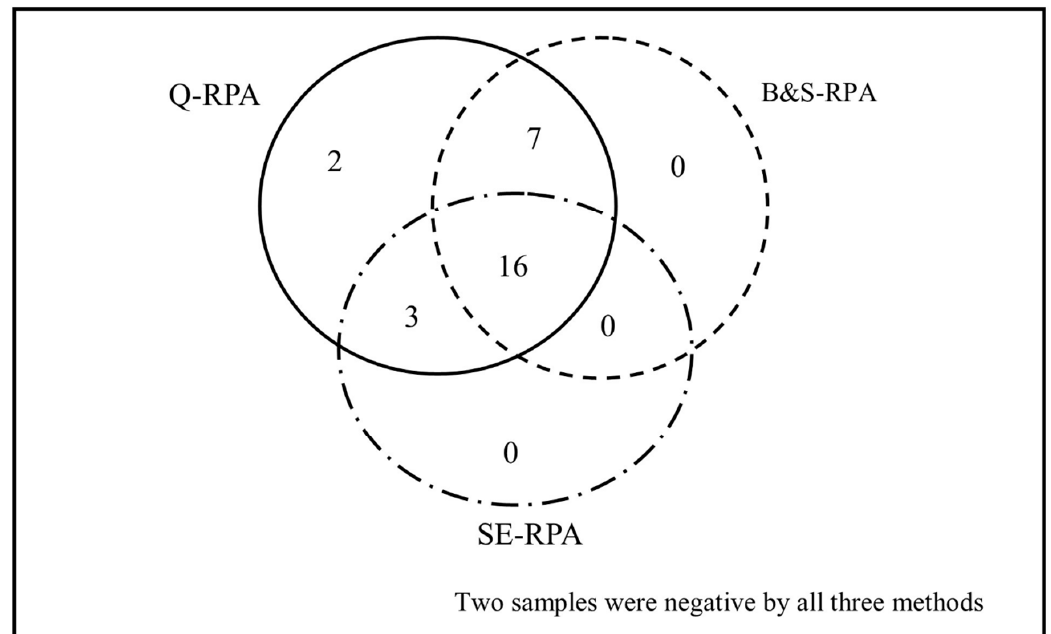
Figure 1. Venn diagram depicting the distribution of Post-kala-azar leishmaniasis detected through Q-RPA, B&S-RPA, and SE-RPA. Among 30 skin biopsy samples from PKDL patients, 28 were positive for L. donovani by Q-RPA, whereas 23 and 19 samples were positive by B&S-RPA and SE-RPA, respectively.